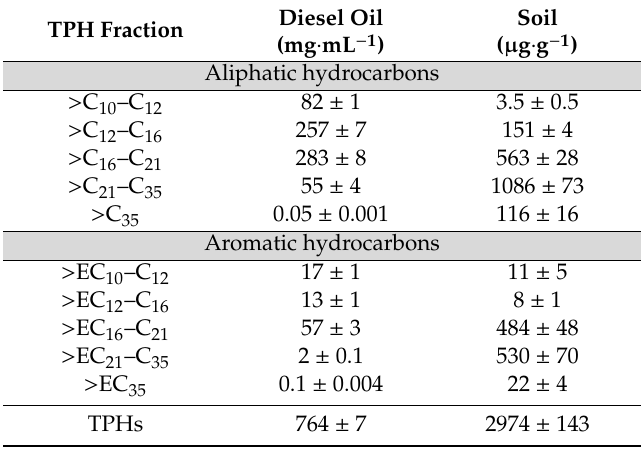
Table 1. Aliphatic and aromatic hydrocarbon fraction composition of the diesel oil and aged diesel- polluted soil used in this